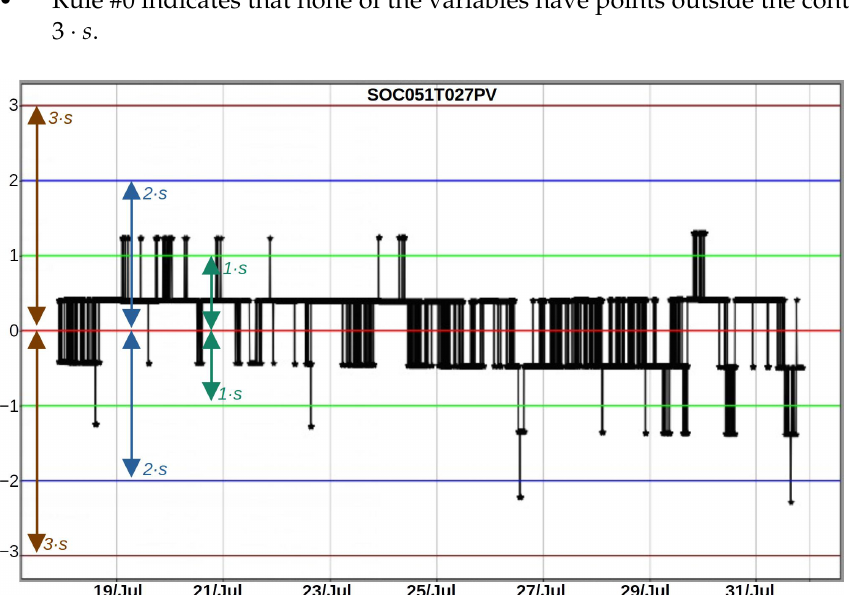
Figure 5. Trend of the variable SOC051T027PV (one of the two temperature sensors of cylinder A6 in the cylinders subsystem) between 17 July 2019 and 31 July 2019.